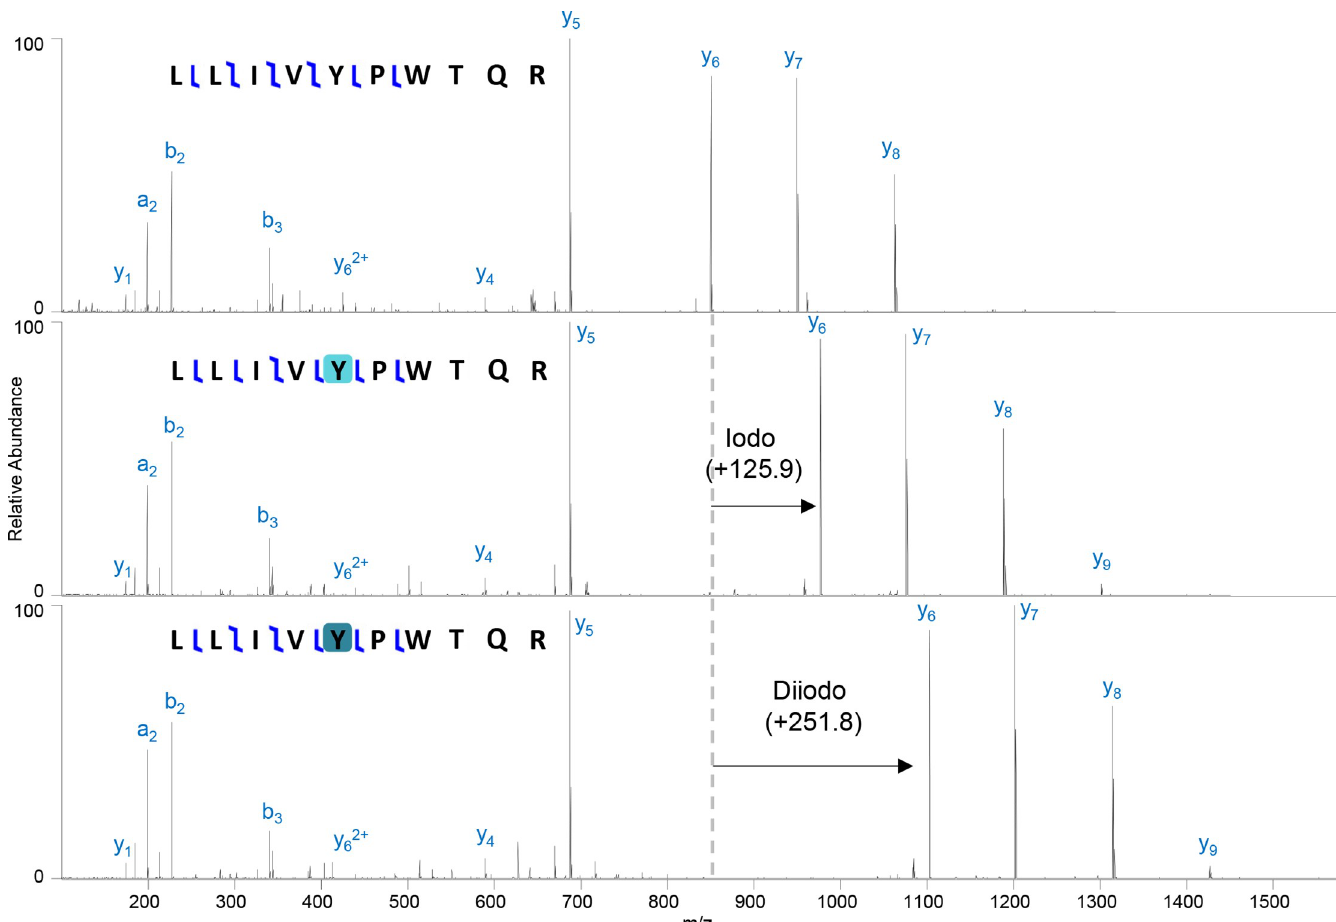
Fig 6. Iodination of hemoglobin. Hemoglobin beta subunit peptide (LLIVYPWTQR) showing unmodified (top), iodination (middle), and di-iodination (bottom) on tyrosine. Iodination is indicated with light blue and di-iodination is indicated with teal. Fragments y 6 , y 7 , y 8 , y 9 show the mass shift corresponding to the addition of